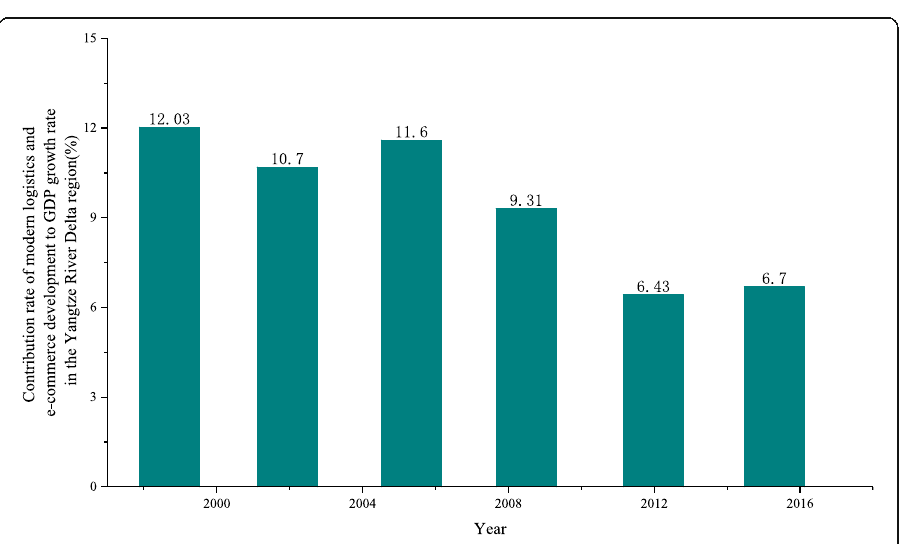
Fig. 7 Contribution rate of logistics industry and e-commerce industry to GDP